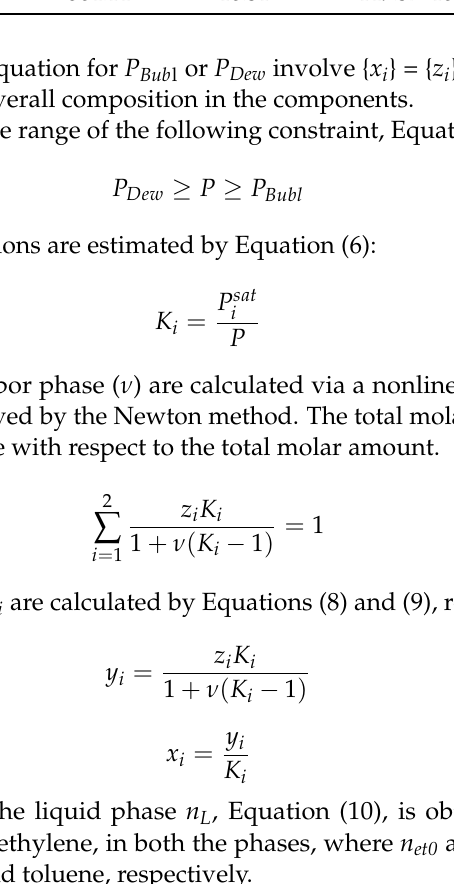
Table 1. Parameters used in the Antoine equation for toluene and ethylene. Component i A i B i C i Temp. Range (K) Ref. Toluene